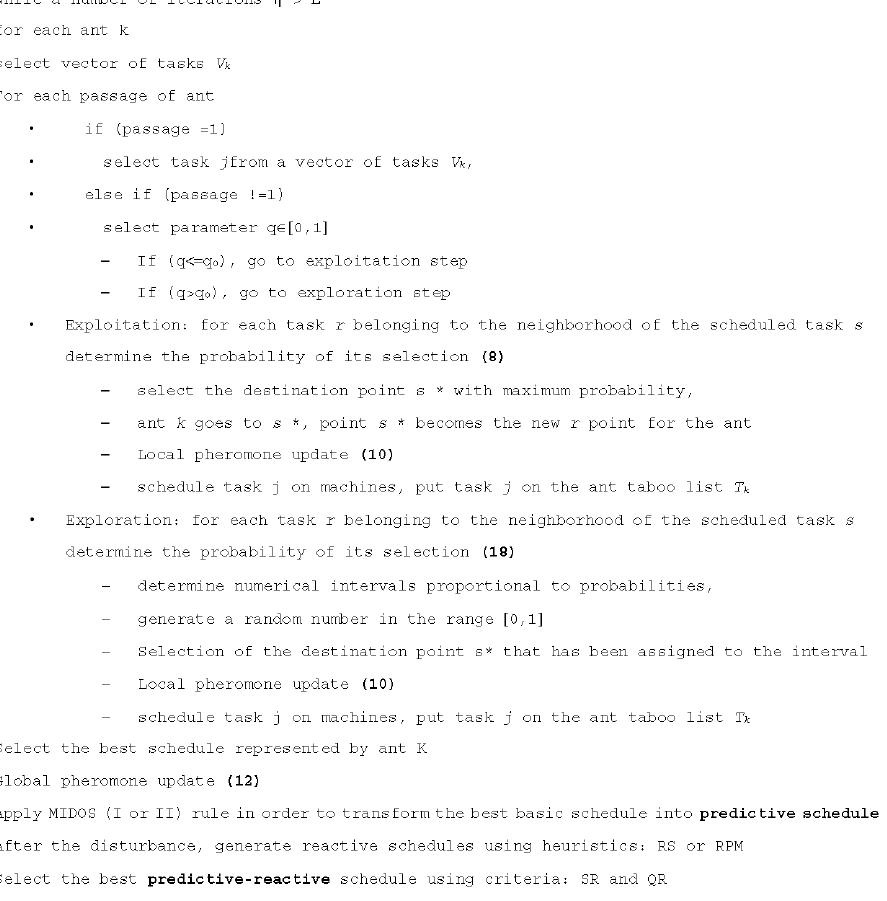
Figure 2. The steps of the ACO.